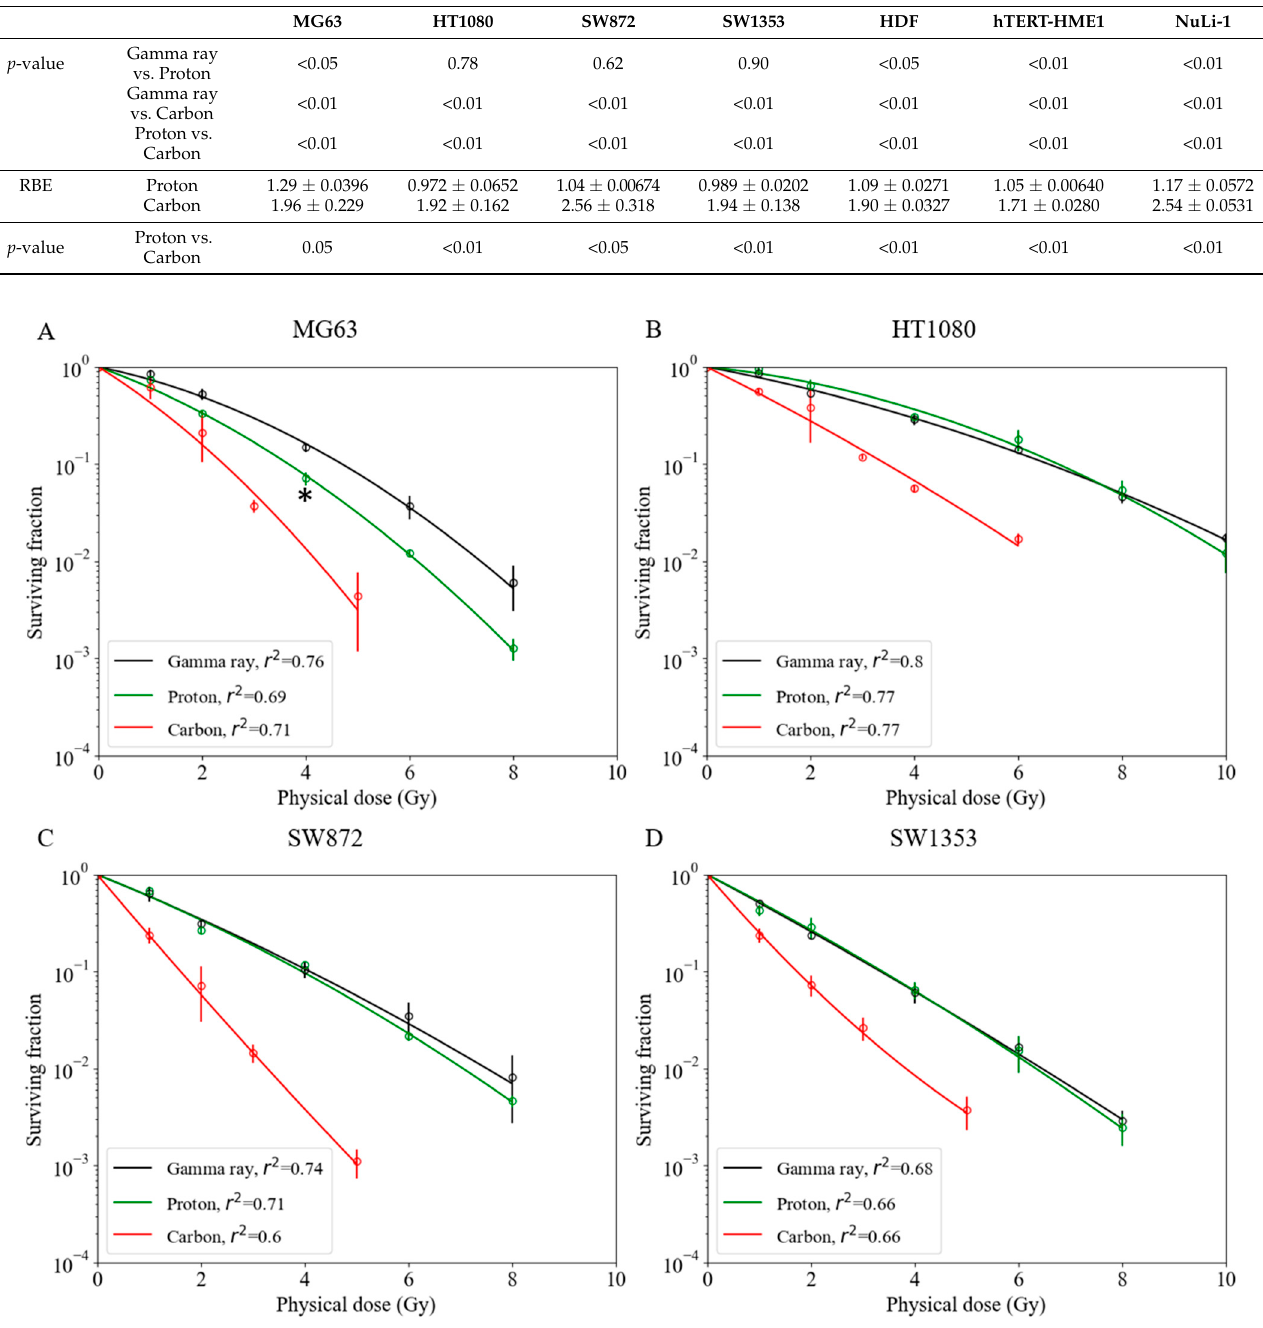
Figure 1. Survival fractions among various human sarcoma cell lines with gamma ray, proton beam, and carbon-ion irradiations. ( A ) MG63 osteosarcoma cell line; asterisk: * p < 0.05 ( t -test). ( B ) HT1080 fibrosarcoma cell line. ( C ) SW872 liposarcoma cell line. ( D ) SW1353 chondrosarcoma cell line. Bars represent confidence intervals of one standard deviation. A minimum of three repeated experiments were performed for each irradiation